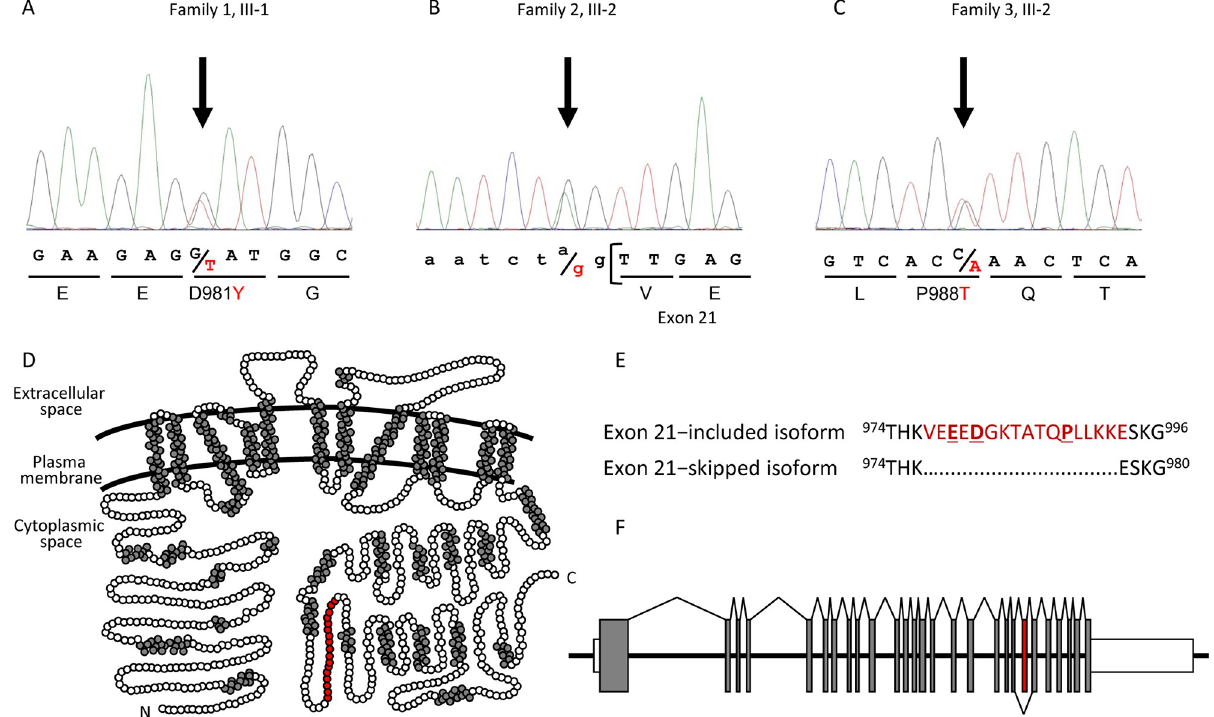
Fig 2. SLC12A2 and the variants detected in this study. (A–C) Partial electropherograms showing heterozygous variants detected in the probands from families 1 (A), 2 (B), and 3 (C; reverse complementary sequence). (D) Schematic structure of SLC12A2 (GenBank: NP_001037.1, based on [34]). The plasma membrane is indicated by curved lines. Amino acid residues contributing to putative helical structures, and those encoded by exon 21, are shown by gray and red circles, respectively. (E) Partial amino acid sequences of the exon 21-included isoform ( top ) and exon 21-skipped isoform ( bottom ). Numbers indicate the positions of both ends of the protein region. The exon 21-encoded region is indicated in red. p.979E, 981D, and 988P are indicated in bold letters and underline. (F) Genomic structure of SLC12A2 . Exons with protein-coding regions are shown by gray boxes. Exon 21 is indicated by a red box. Untranslated regions are shown by white boxes. Splice junctions are connected by lines, to indicate that both the exon 21-included ( top ) and -skipped ( bottom ) variants are transcribed.